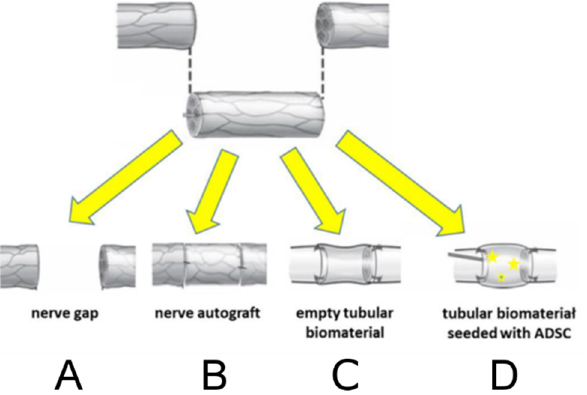
Figure 12. Diagram represents four interventions (groups) to the sciatic nerve. After sciatic nerve transection and excision of 10 mm trunk: ( A ) Nerve gap remained; ( B ) Excised trunk was rotated 180° and used as an autograft; ( C ) P(LLA-CL)-COL-PANI conduit was inserted in the gap; ( D ) P(LLA-CL)-COL-PANI enriched with ASCs was inserted in the gap.